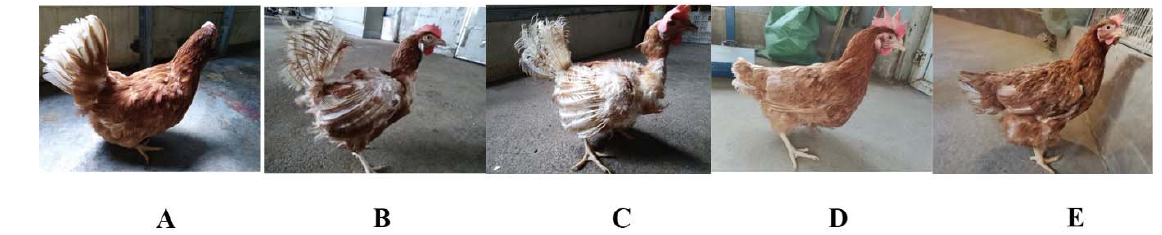
Table 1. Description of chicken population information before and after molting in five different sampling periods.